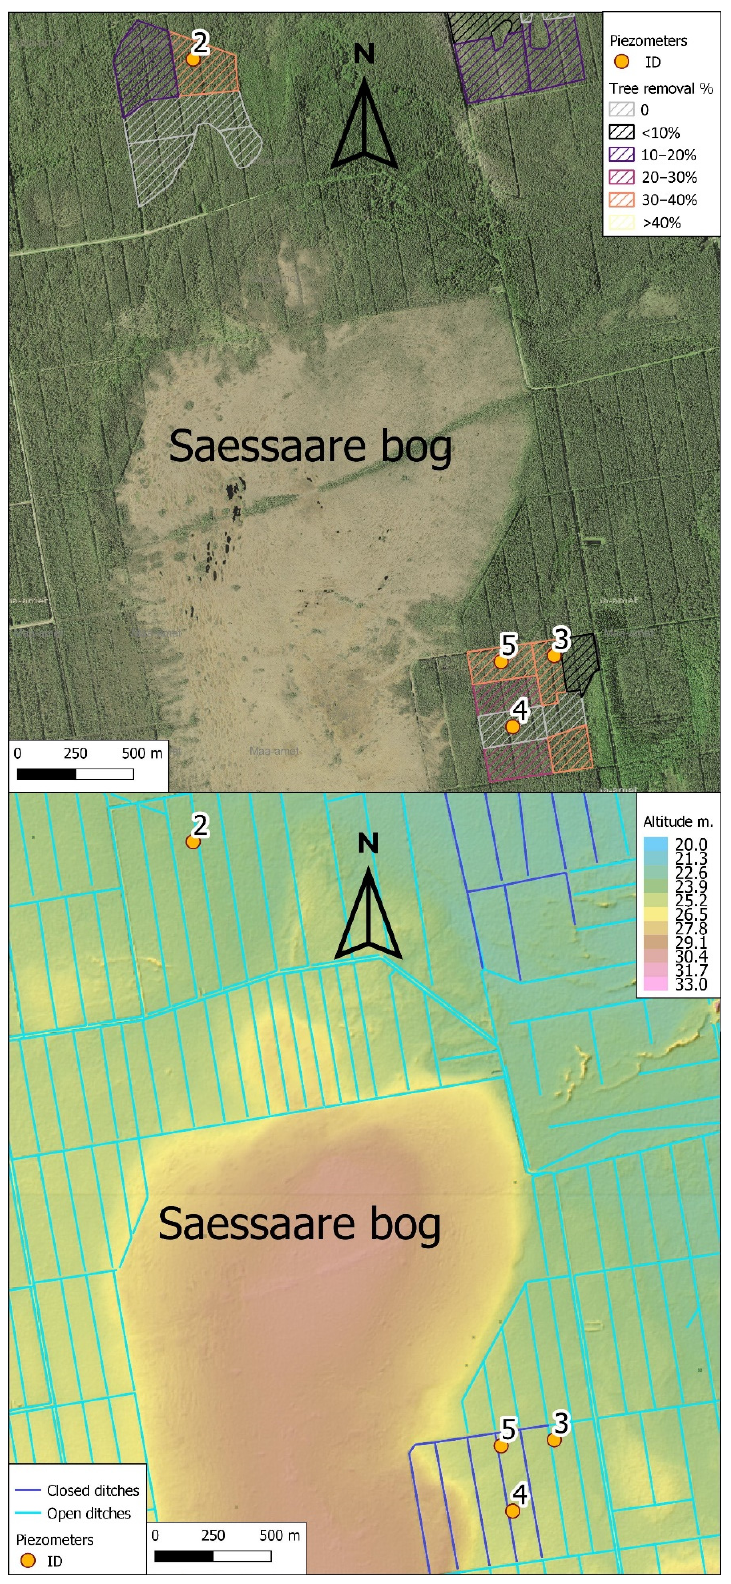
Figure 2. Ortophoto, digital terrain model, locations of the forest manipulations, and piezometers in the southern part of the study area, Kikepera Nature Reserve (data from the Estonian Land Board).